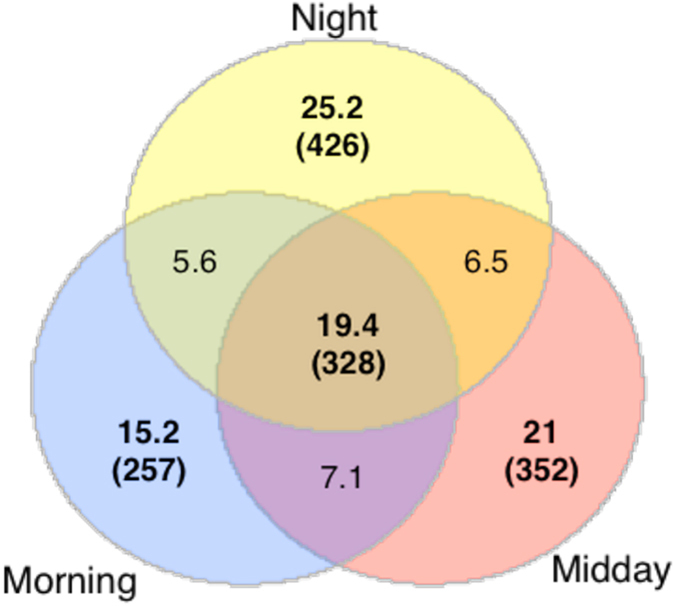
Venn diagram representing the percentage dispersal of bacterial OTUs.The data was resampled to lowest level (>14,000 sequences, 1688 OTUs0.03) between time-points. The number of reads are in parenthesis.